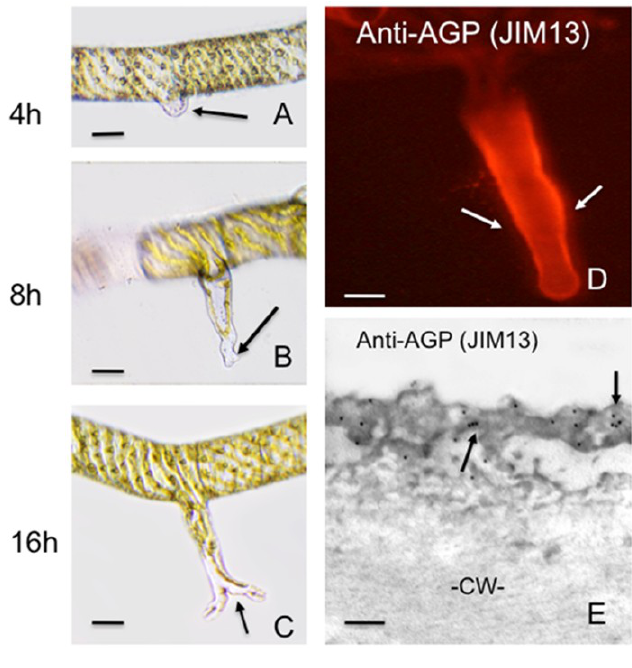
rhizoid (arrow) from the cell adjacent to a cell artificially wounded ( i.e. , cut) 4 h earlier. DIC image. Bar = 20 µm; ( B ) displays the rhizoid 8 h after wounding. Note that branching occurs at the tip (arrow). DIC image. Bar = 20 µm; ( C ) shows the rhizoid after 16h and the extensive branching that has taken place. DIC image. Bar = 20 µm; ( D ) shows a rhizoid labeled with the anti-AGP antibody, JIM13. Note that only the rhizoid wall labels (arrow). CLSM image. Bar = 15 µm; ( E ) is a JIM13 immunogold labeling of the rhizoid wall, Note that a sheath (arrows) external to the main cell wall (CW). Transmission electron microscopy (TEM) image. Bar = 100